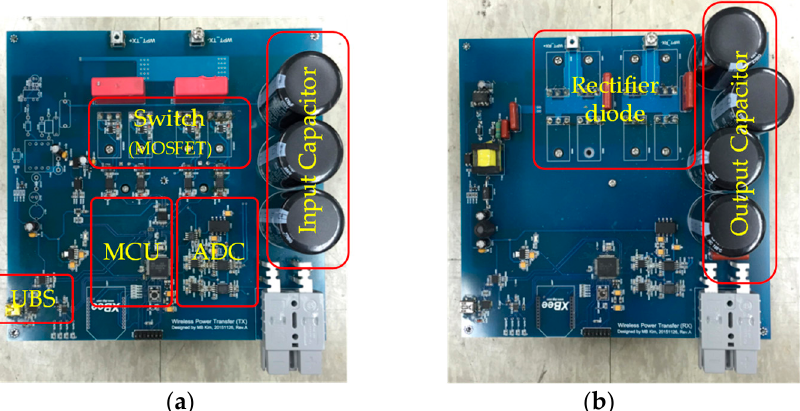
Figure 10. Prototype of the full-bridge series resonant converter. ( a ) Transmission module; ( b ) re- ceiver module.